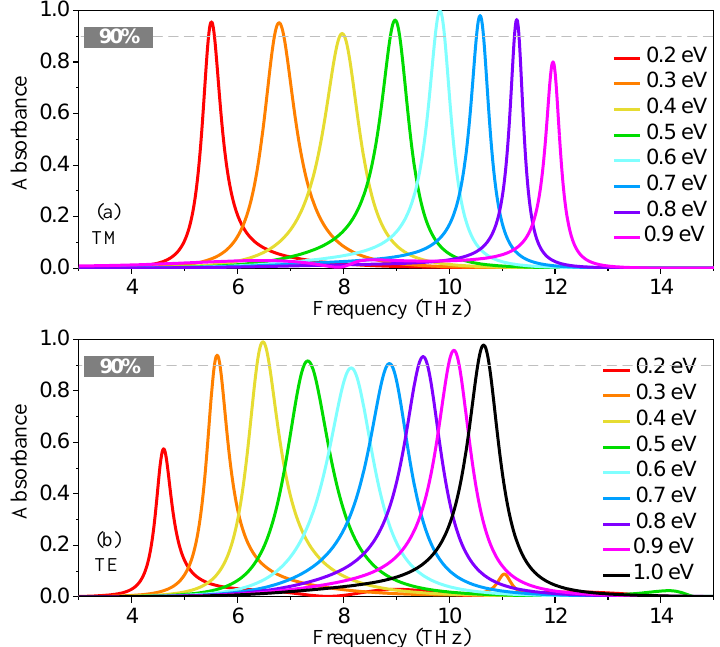
Figure 5. Simulated absorbance spectra of the proposed absorber with DLDGRAs with different µ c under normal terahertz incidence. ( a ) Absorbance spectra for TM polarization with µ c ranging from 0.2 to 0.9 eV; ( b ) absorbance spectra for TE polarization with μ c ranging from 0.2 to 1.0 eV.